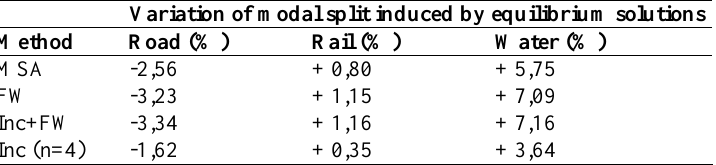
Table 7. Impact on the estimated modal